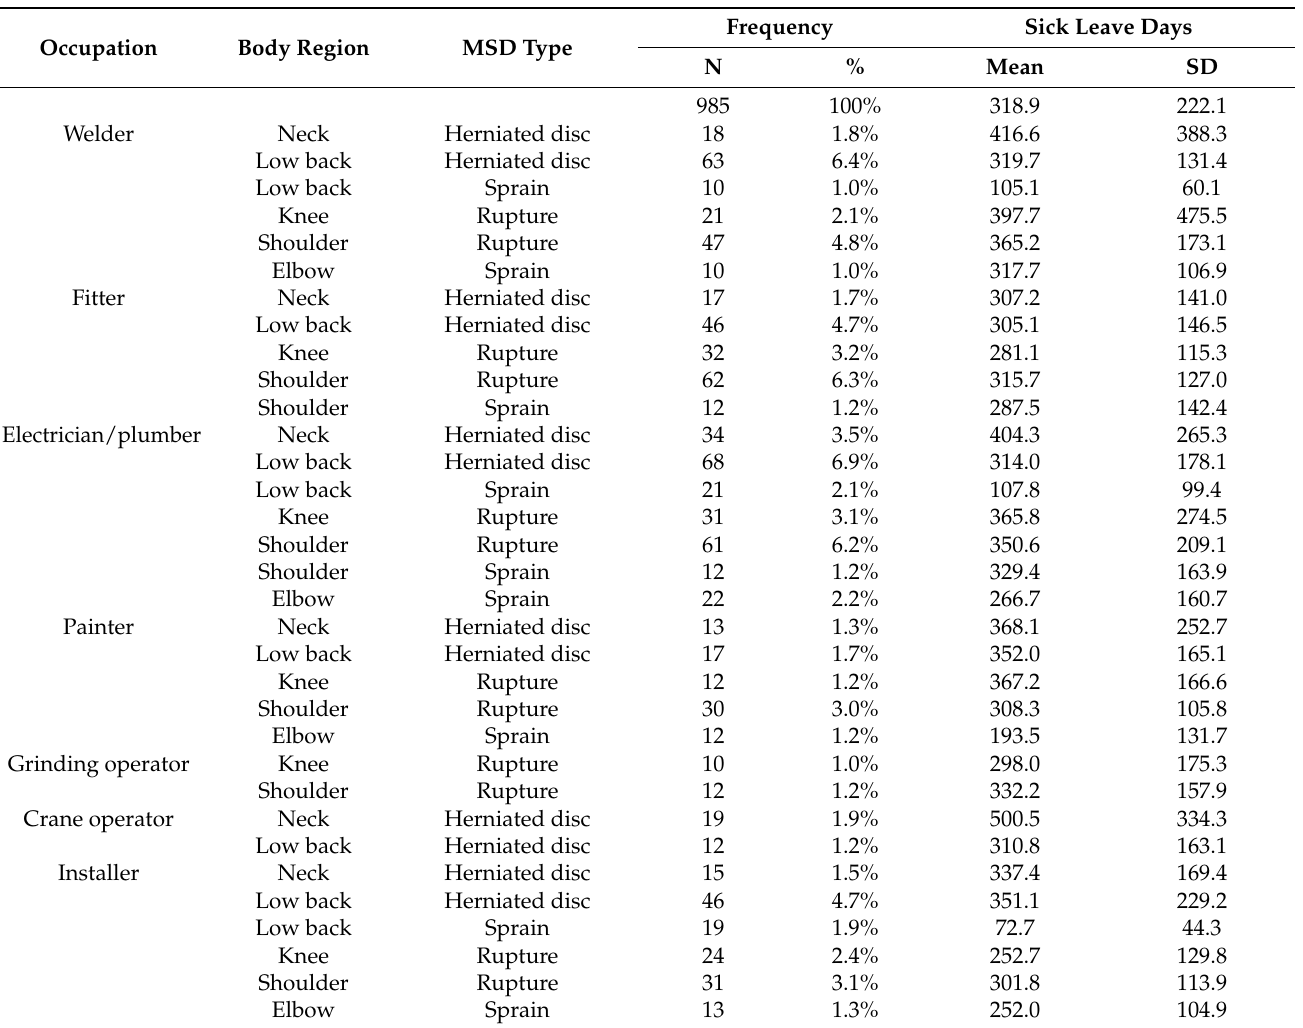
Table 1. Distribution and sick leave days of the MSDs according to occupation–body region– MSD